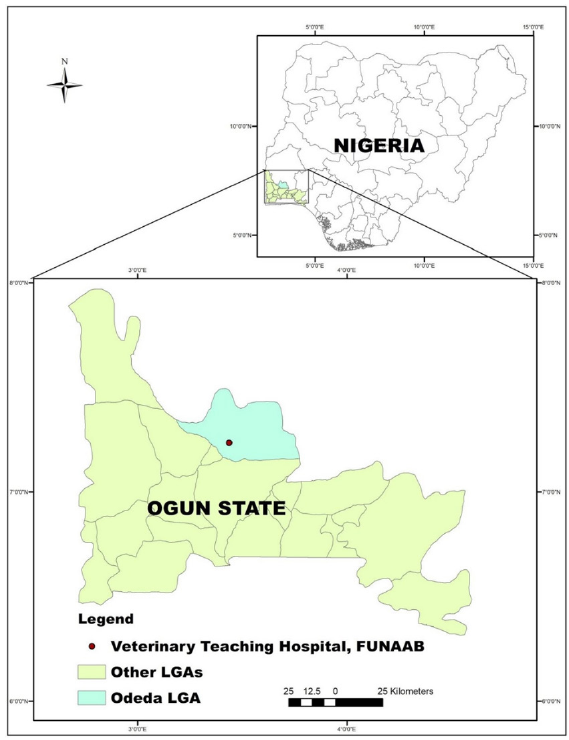
Figure 1 Spatial representation of the Veterinary